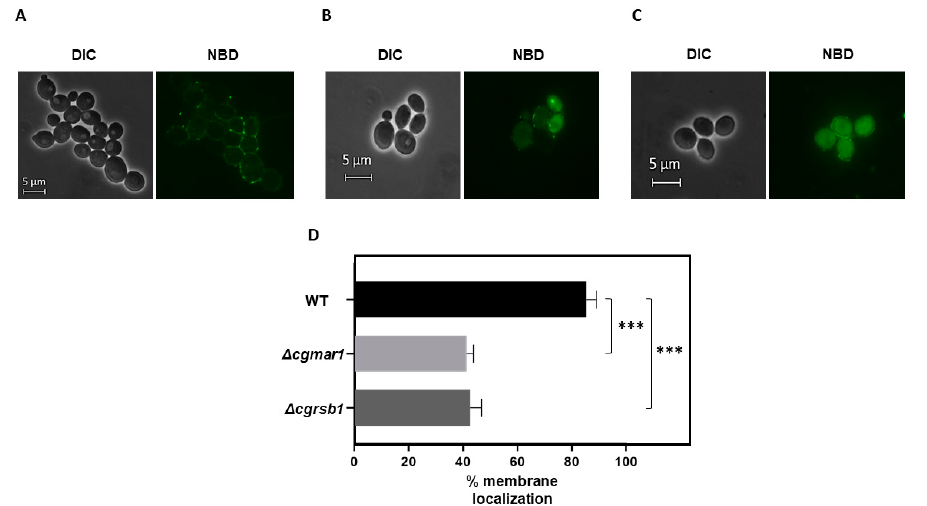
Figure 3. CgMar1 and its activated target CgRsb1 contribute to DHS incorporation in the plasma membrane. ( A ) Representative images of KUE100 C . glabrata wild-type cell fluorescence upon incorporation of NBD-DHS. ( B ) Representative images of KUE100_ ∆ cgrsb1 C . glabrata cell fluorescence upon incorporation of NBD-DHS. ( C ) Representative images of KUE100_ ∆ cgmar1 C . glabrata cell fluorescence upon incorporation of NBD-DHS. ( D ) Percentage of cells showing membrane localization of the NBD-DHS probe. Values are the averages of at least three independent experiments. Error bars represent the corresponding standard deviations. *** p -value < 0.001; DIC—Differential Interference Contrast; NBD—Nitrobenzoxadiazole lipid labeling